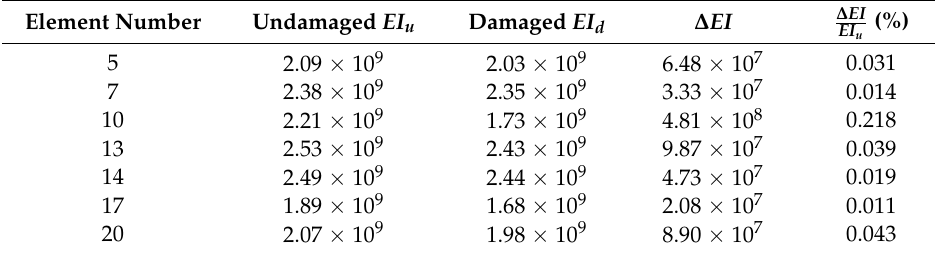
Table 5. Stiffness change of partial unit of case